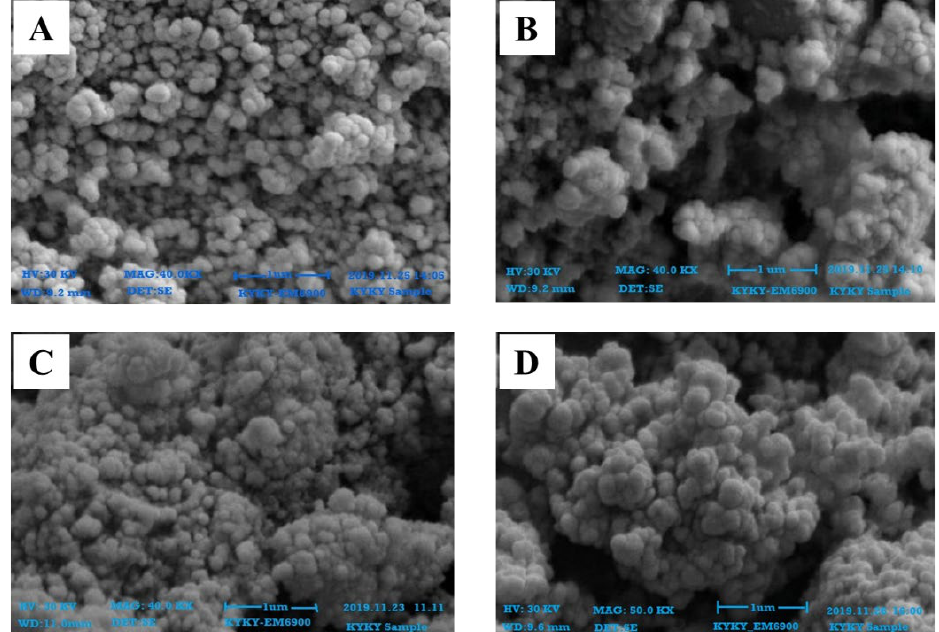
Figure 4. SEM images of zinc oxide nanoparticles of leaves; (A) n-Hexane ( B ) Ethyl Acetate ( C ) Methanol ( D ) Aqueous.